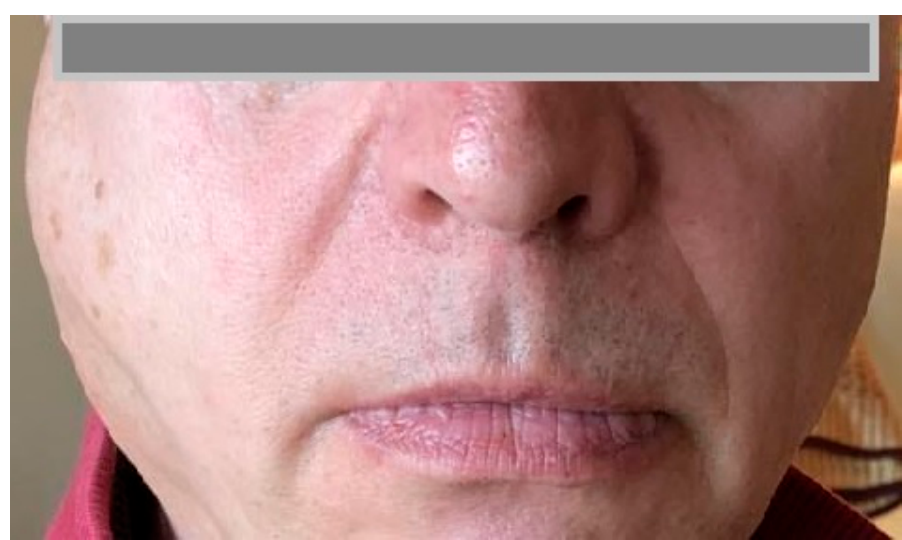
Figure 4. Visualization of such a swelling on the postoperative day. The swelling was gone 2 days later without any therapy. The bleeding takes place in a closed compartment. In some cases the swelling is visible only cranially to the zygomatic arch.